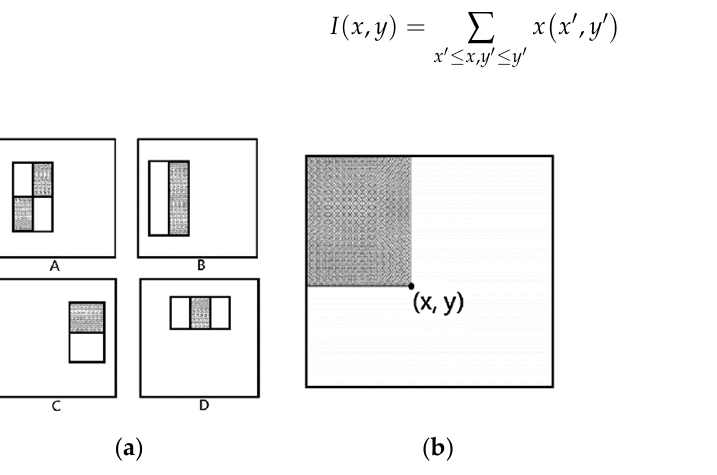
the pixel position in the original image.